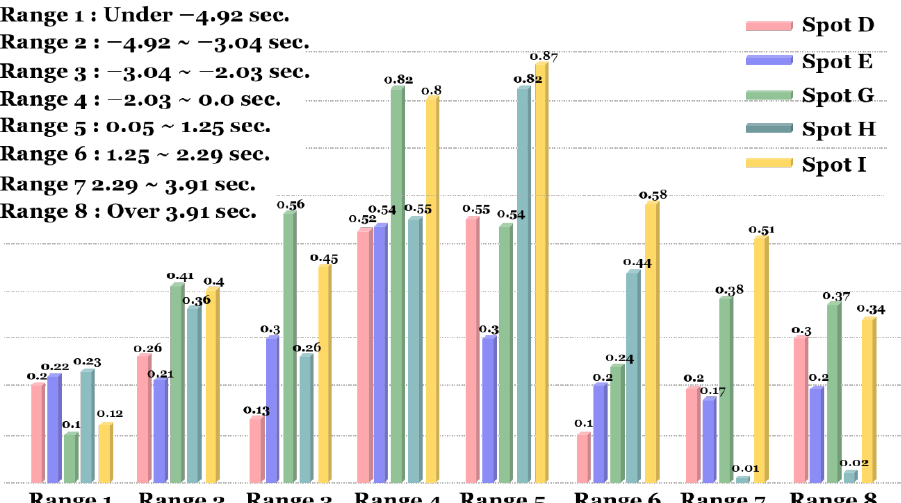
Figure 18. The percentages of drivers stopping before the crosswalk by PSM range.